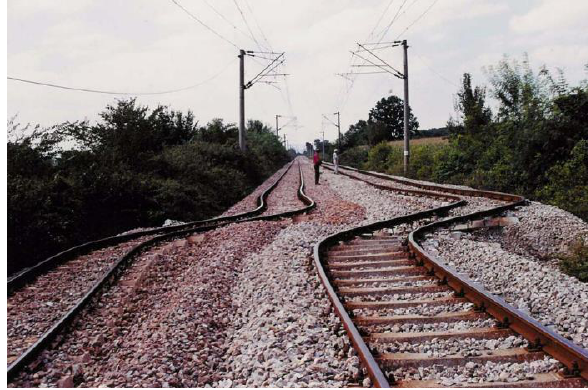
Figure 6. An example to surface rupture from Golcuk, Turkey, occurred after August 17, 1999 earthquake (Arpat,